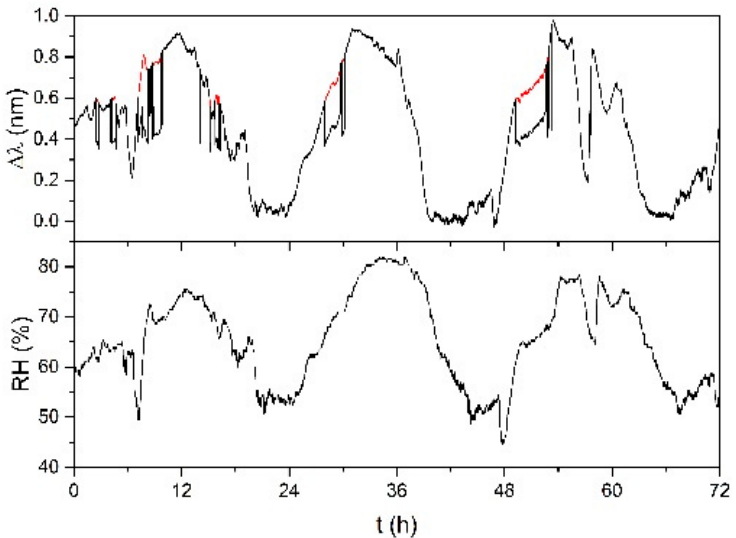
Figure 7. Response of sample FBG-ACET for three days in May (black); red sections are discussed in the text. RH value was measured by the reference thermo-hygrometer.